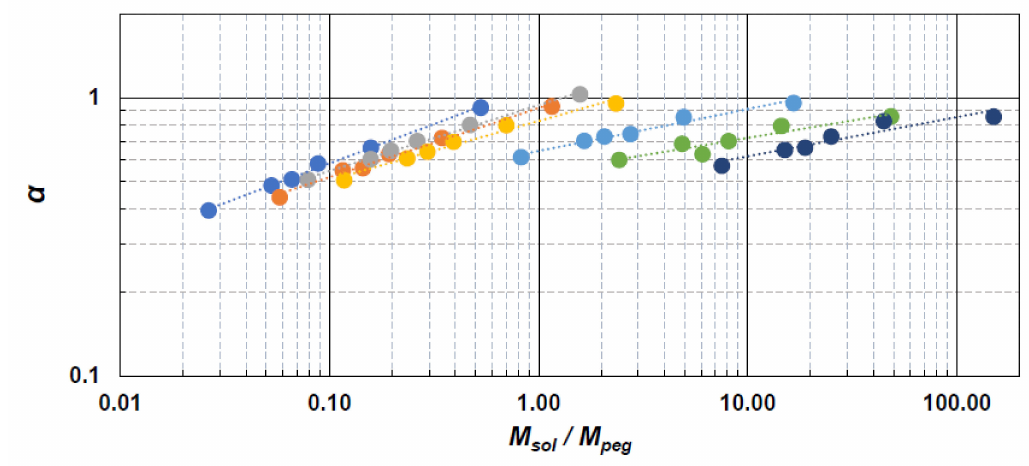
Figure 4. The anomalous index α depends on M sol / M peg . Blue, orange, grey, yellow, light blue, green and dark blue dots correspond to the α value of TAMRA, ALEXA, 10-mer TAMRA, 16-mer TAMRA, Brd2, sesernin-1 and ALEXA-IgG obtained in various molecular weight PEGs, that is PEG1000, PEG3350, PEG6000, PEG8000, PEG10,000 and PEG20,000. Colored dotted lines show exponential approximations for the corresponding